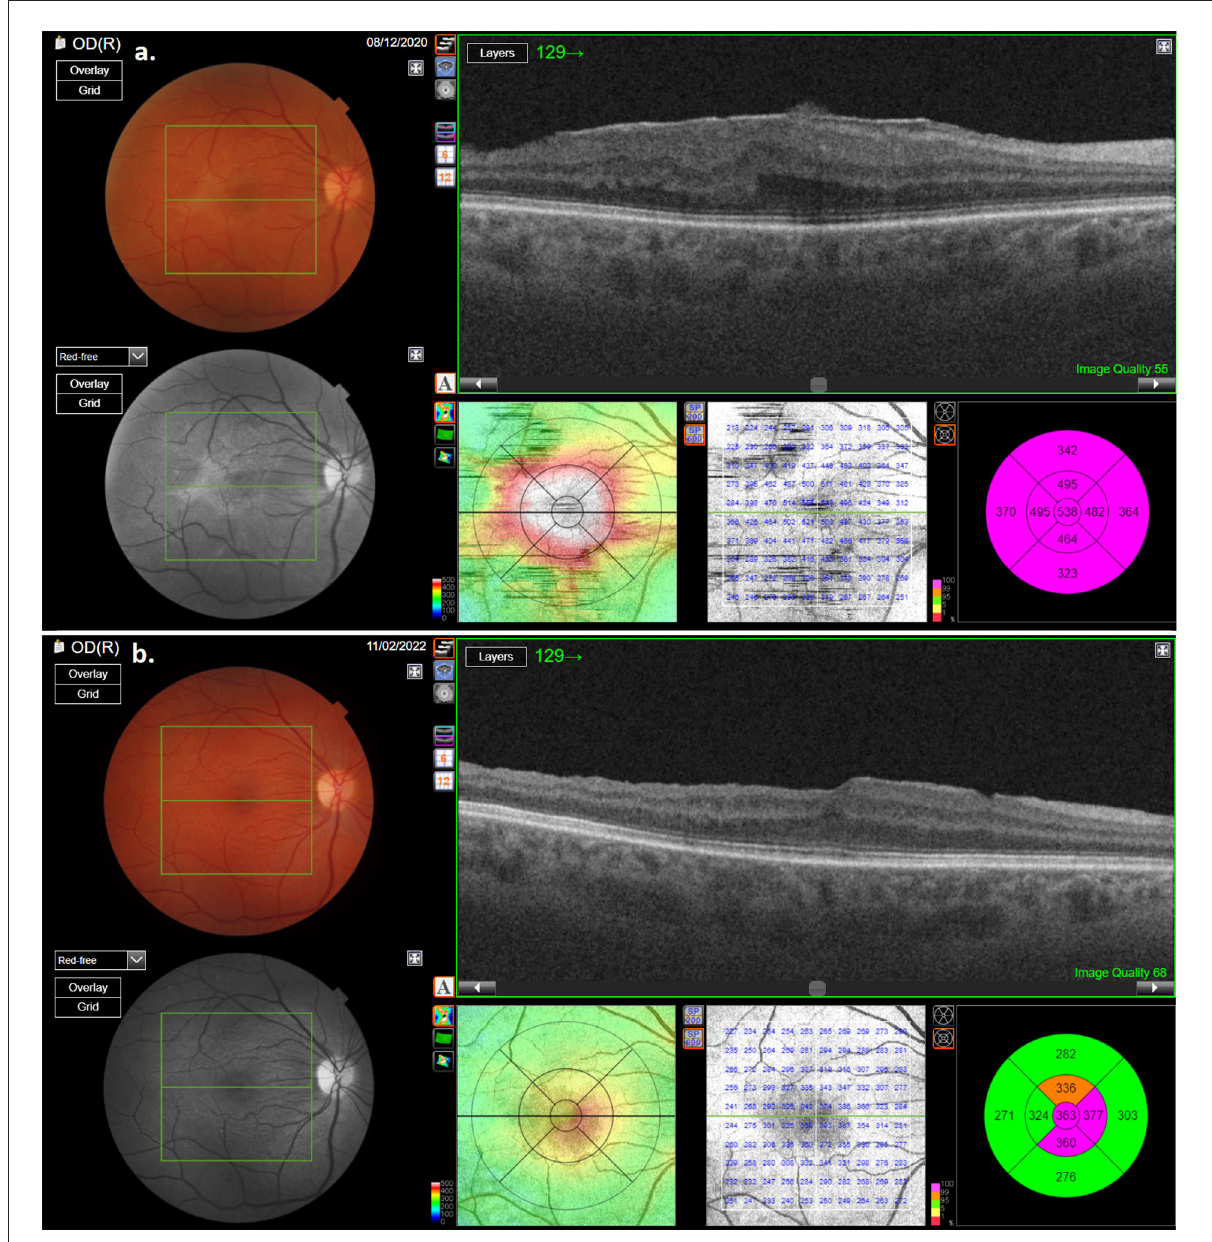
FIGURE3 OCT scan of one of the patients with macular pucker: (a) pre-operative OCT scan showing thick macular pucker; (b) OCT scan of the same patient after surgery.